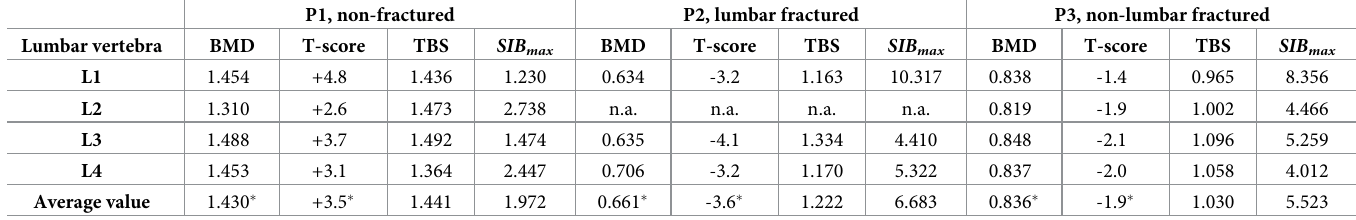
Table 2. Summary of BMD (g/cm 2 ), T-score, TBS and SIB max (10 4 mm/mm) for each vertebra of three case-studies on